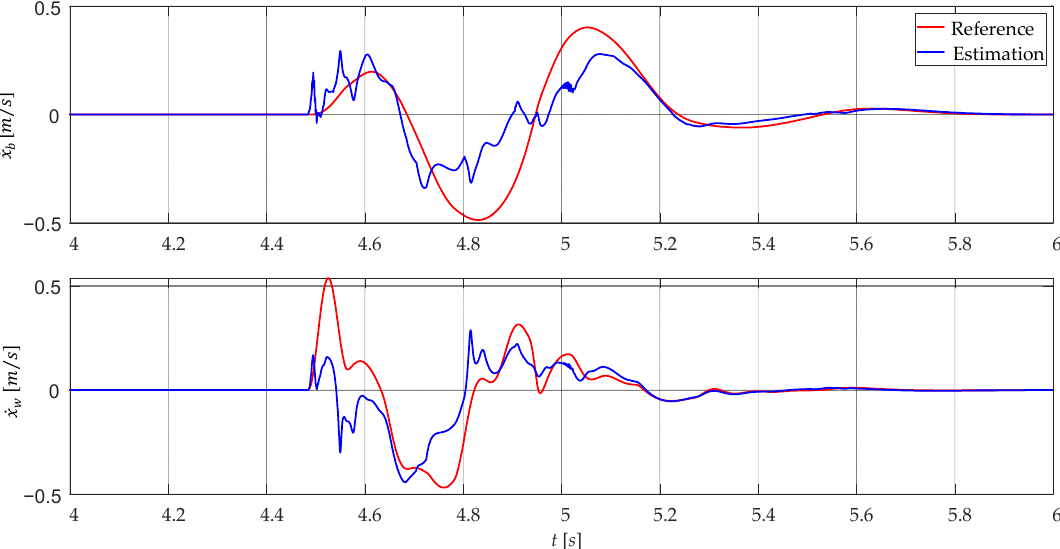
. . x b and wheel x w from the simulation in TargetLink (blue) and the